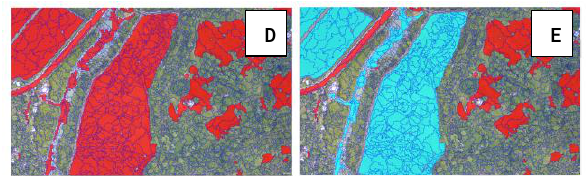
Figure 4. Flat Surfaces (D) to Water (E) object classification using assign class algorithm with mean DSM maximum threshold value of 63.5.